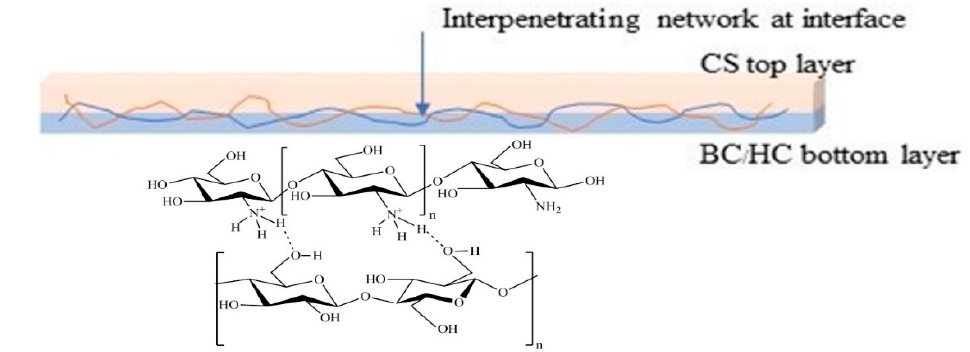
Figure 3. Cross ‐ sectional SEM images of BC, CS, BC90:HC10, BC80:HC20, BC70:HC30, CS ‐ coated Figure 3. Cross-sectional SEM images of BC, CS, BC90:HC10, BC80:HC20, BC70:HC30,